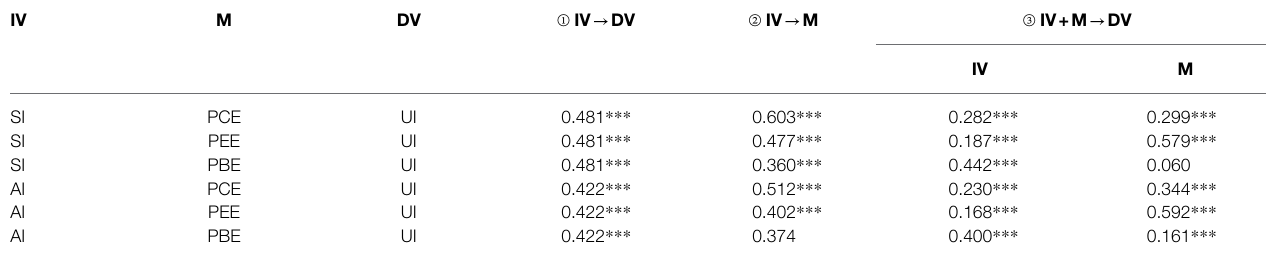
TABLE 6 | Results of the mediating effect testing.